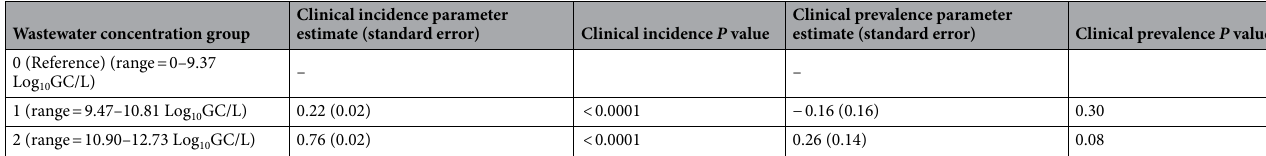
Table 1. Test of linearity among SARS-CoV-2 wastewater concentrations and COVID-19 clinical outcomes. Poisson regression analysis of SARS-CoV-2 wastewater concentration tertiles and weekly COVID-19 clinical incidence and clinical prevalence.